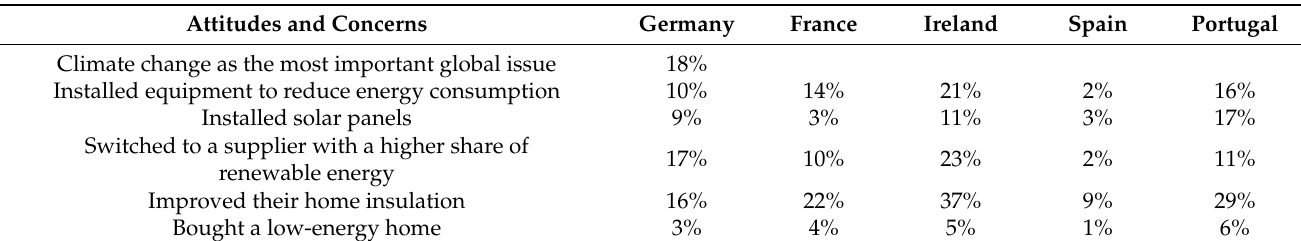
Table 1. Attitudes and concerns toward energy consumption and the environment among EU